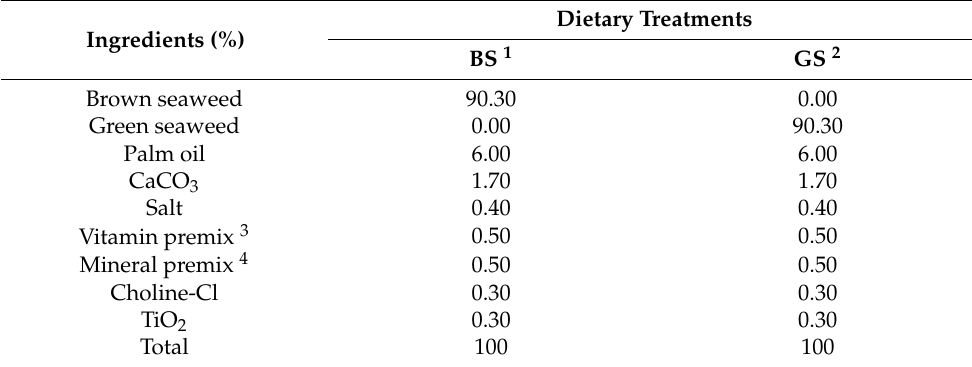
Table 2. Ingredient composition of the experimental diets. Ingredients